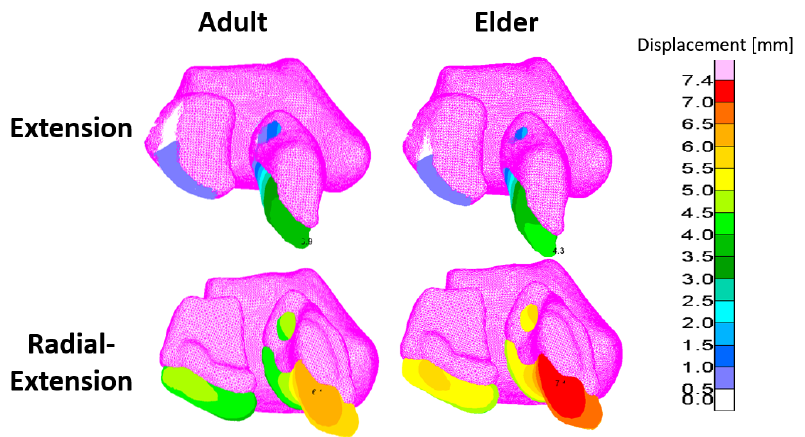
Figure 3. Displacement [mm] plots in superior view of the scaphoid, lunate and the radius for the adult ( left frames ) and elder ( right frames ): extension ( upper frames ), and radial extension ( bottom frames ). The purple colored wireframes show the initial position of the wrist bones . The pitch angles (rotation in the sagittal plane) between the lunate and scaphoid were 27.0° for the extension model and 17.2° for the for radial-extension model.